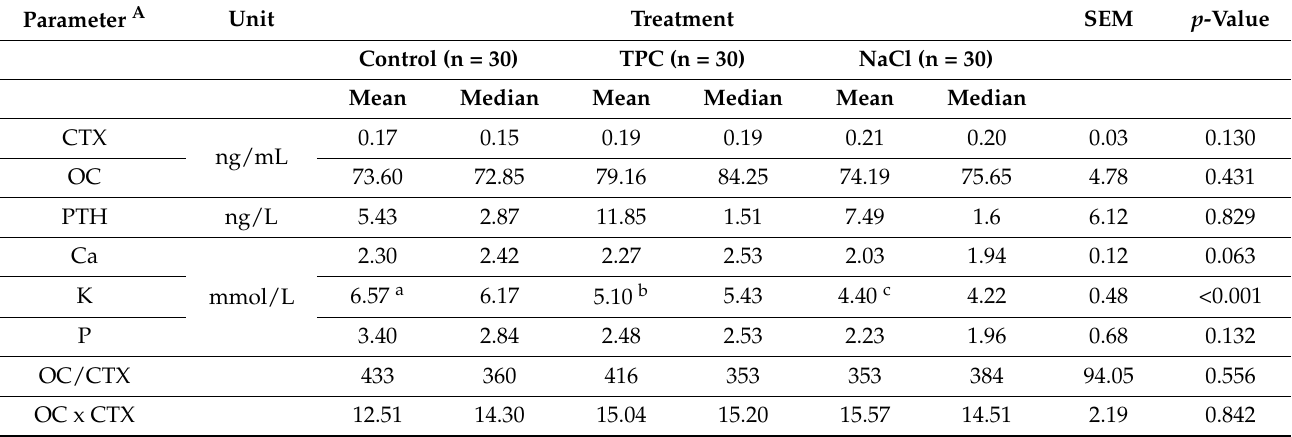
Table 4. Serum concentrations (mean and median) of bone markers, parathyroid hormone (PTH) and minerals in fattening pigs of three treatment groups: the control group (control) received the normal feed used on the farm, the tripotassium citrate (TPC) and the sodium chloride (NaCl) groups received the normal feed supplemented with 0.25% TPC and 0.20% NaCl, respectively. Ten animals were sampled in each replicate at approximately 24 weeks of age (2 to 3 weeks prior to